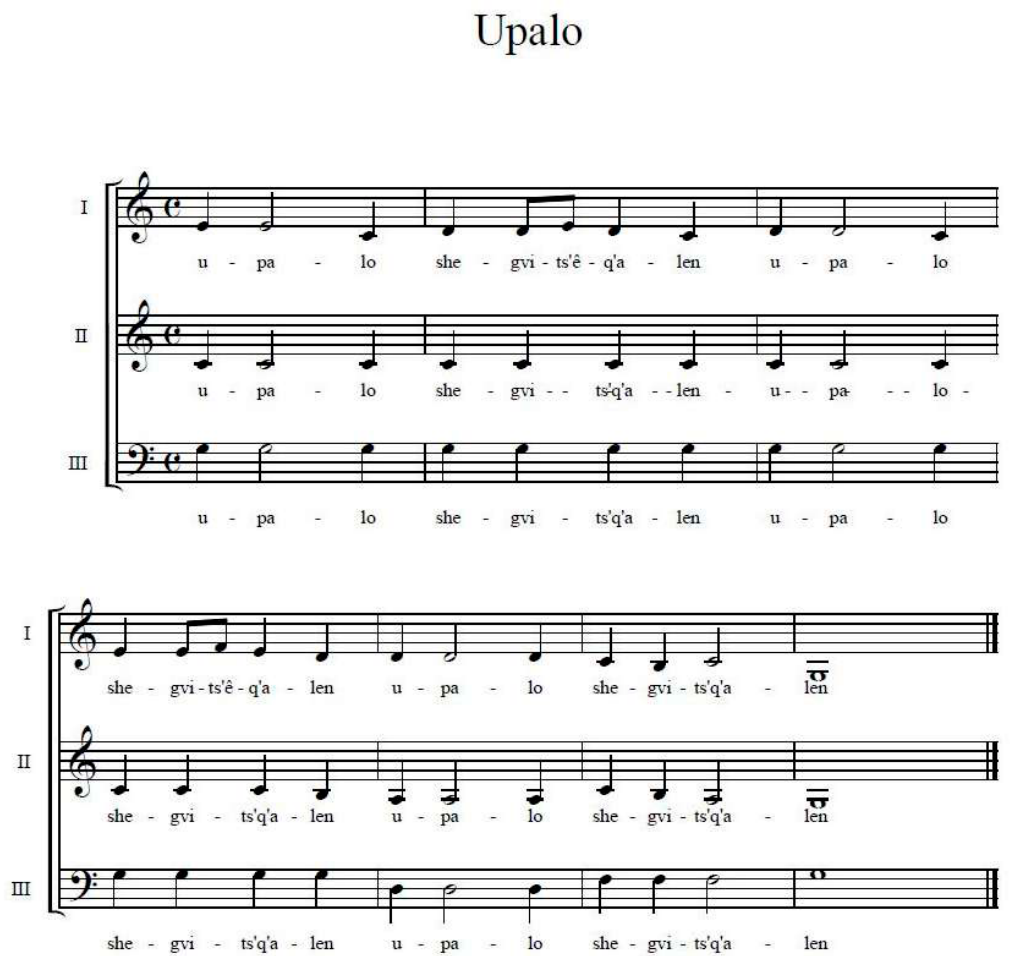
Figure 8. Triple Lord, Have Mercy; plain mode; Upper Svan variant, Lakhushdi Village.